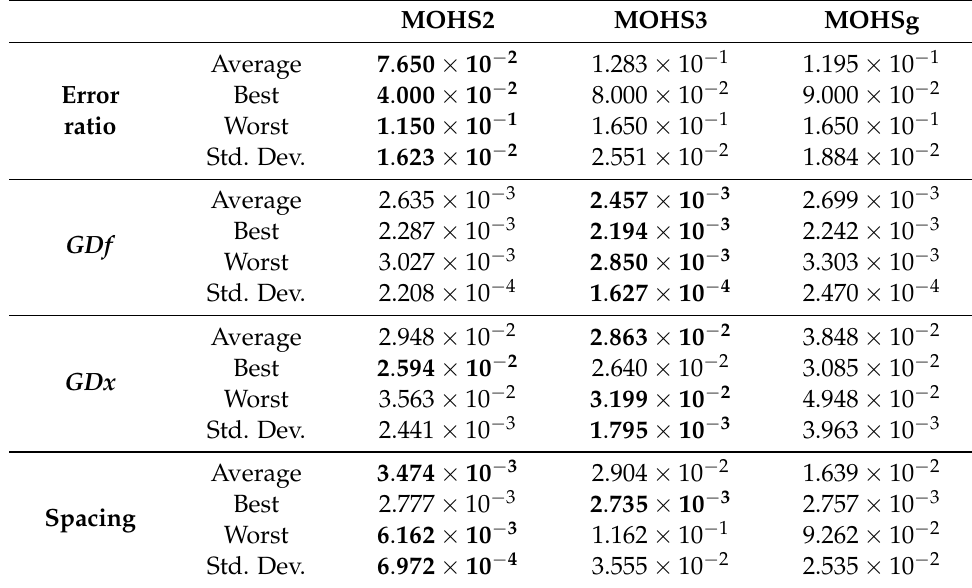
Table 4. Statistic analysis for problem